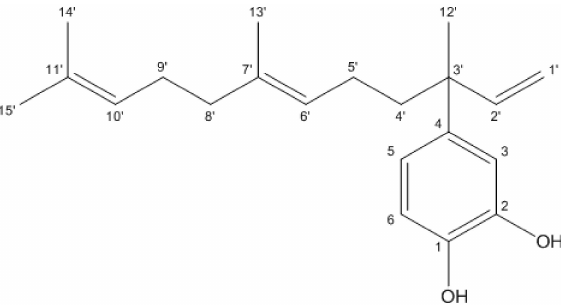
Figure 2. Chemical structure